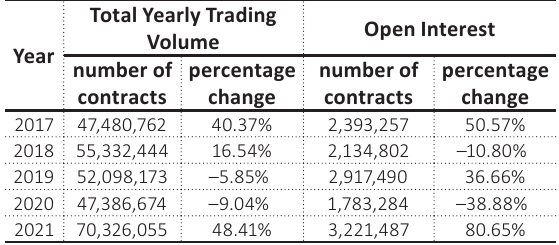
Table 3. Total yearly trading volume and open